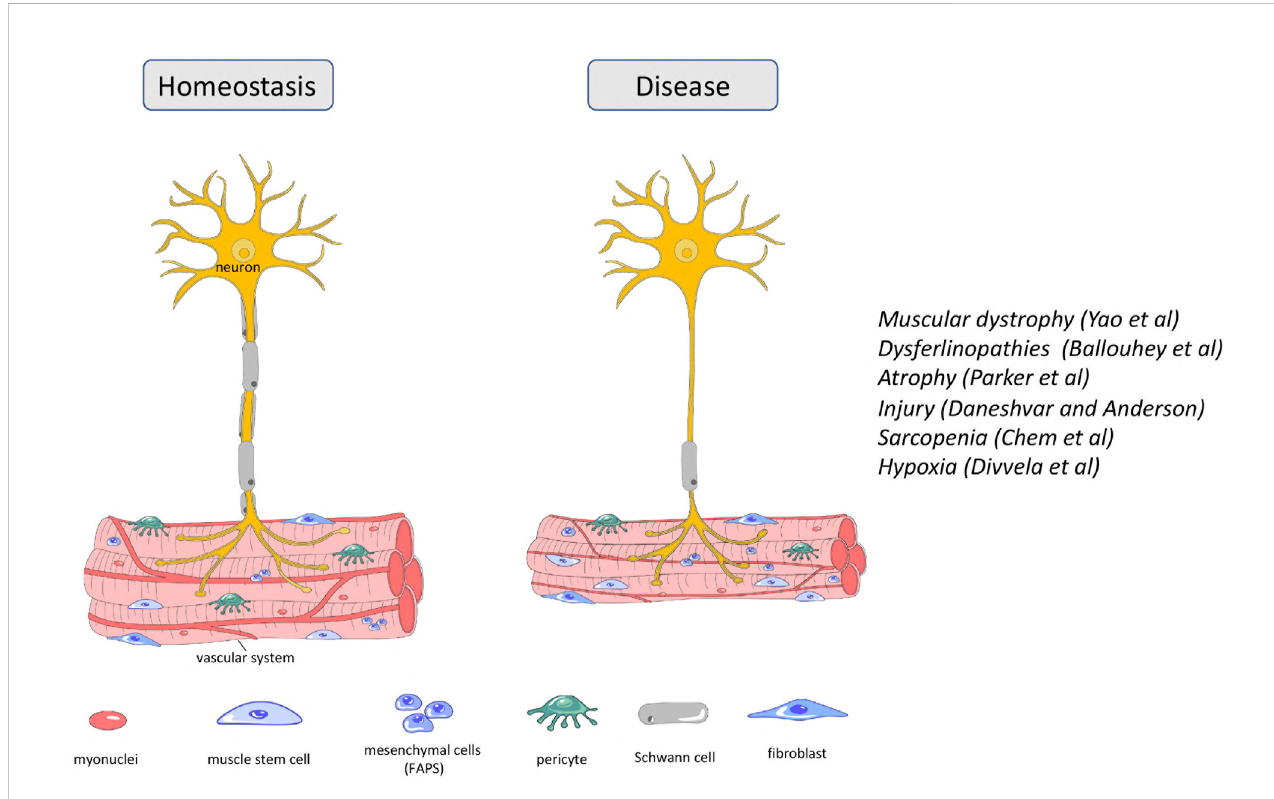
FIGURE 1 Cellular content of neuron and skeletal muscle during homeostasis and disease